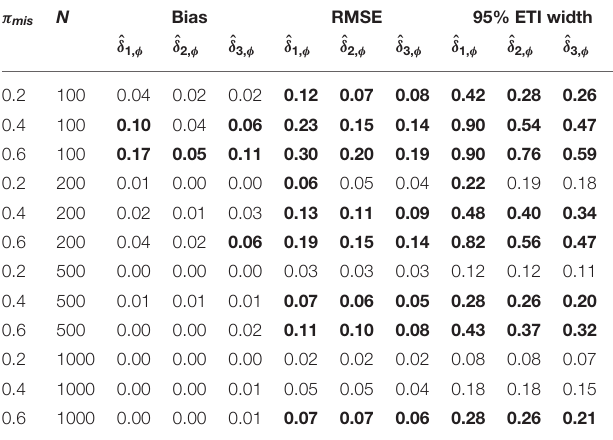
TABLE 3 | The bias, RMSE, and the 95% equal-tailed interval width of factor correlation FMIs under MCAR. π mis N Bias